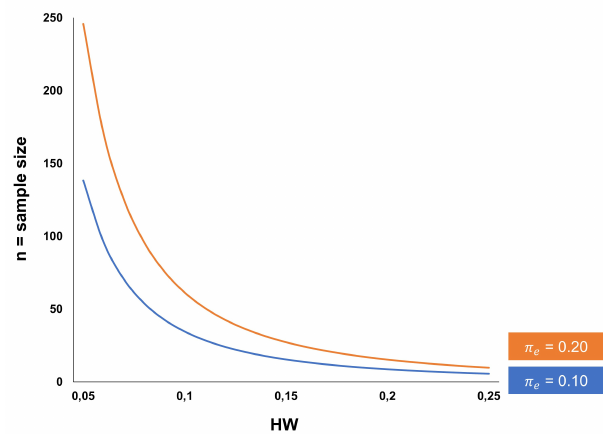
Figure 6. Sample size for half-widths ( HW ) ranging from 0.05 through 0.20, and two expected incidences of a given NC not detected (or not corrected) by the ICS ( π e ), using Equation 8. As explained in the text, this method for deter- mining sample size does not depend on the size of the total population ( N )—provided the population is large